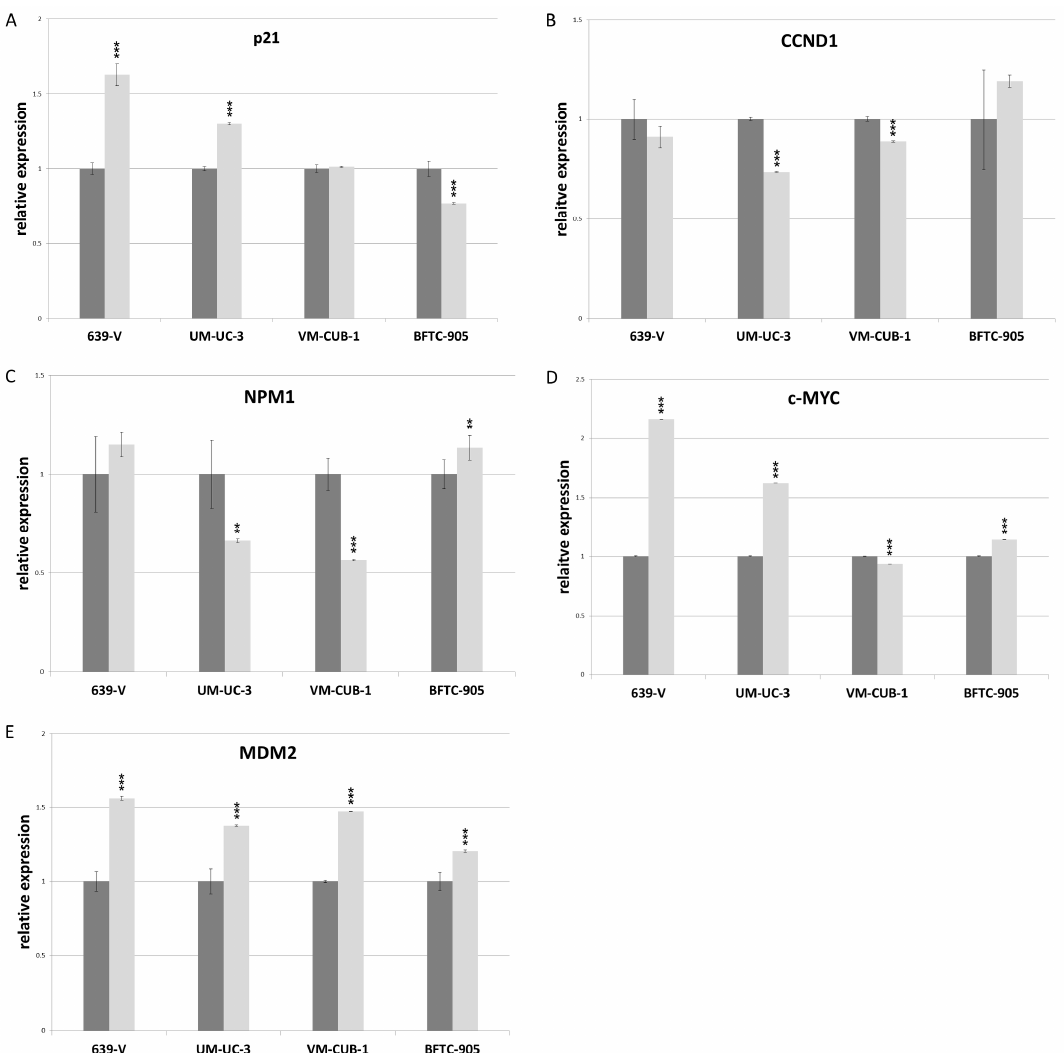
Figure 8. RNA levels of p21 ( A ), CCND1 ( B ), NPM1 ( C ), c-MYC ( D ) and MDM2 ( E ) after double knockdown of GCN5 and PCAF in 639-V, UM-UC-3, VM-CUB-1 and BFTC-905 (from left to right). All values were determined by qRT-PCR, adjusted to TBP mRNA as a reference. Dark bars: irrelevant siRNA (values set as 1 for each cell line); light bars: GCN5 + PCAF siRNA. Asterisks denote significant differences, ** p < 0.01, *** p < 0.001.